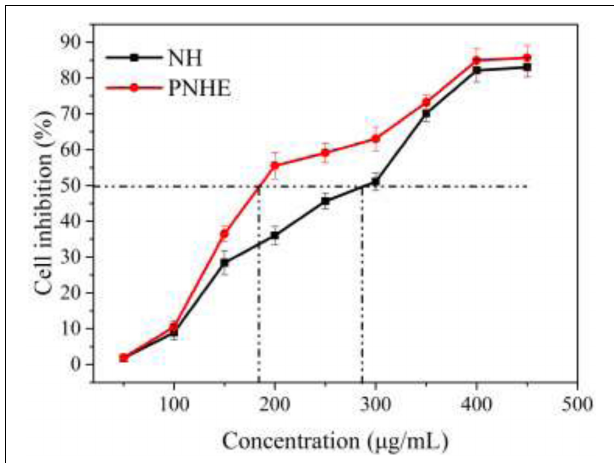
FIGURE 5 | The anti-proliferative effect of NH and PNHE on MCF-7 cells after 24 h treatment. Data are expressed as a percentage of the corresponding control group, and are described as means ± SD ( n = 6).